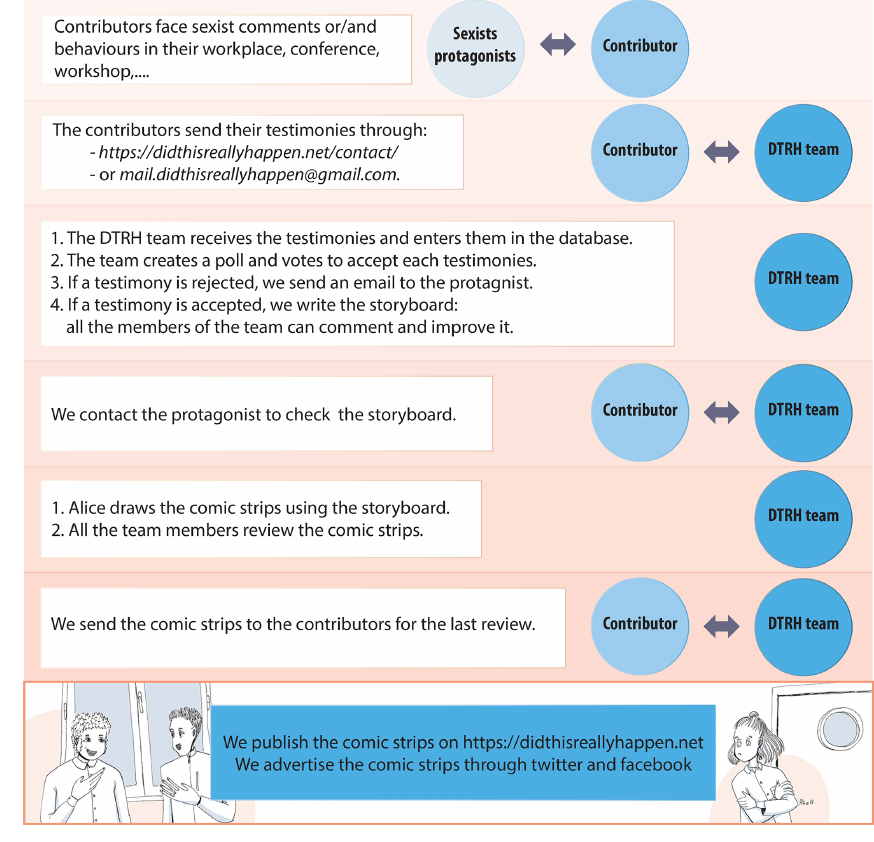
Figure 1. Procedure of creation of a comic strip from the testimony of a given contributor. All comics are hand-drawn by Alice Adenis – distributed under the Creative Commons Attribution 4.0 License. DTRH stands for Did this really happen?!